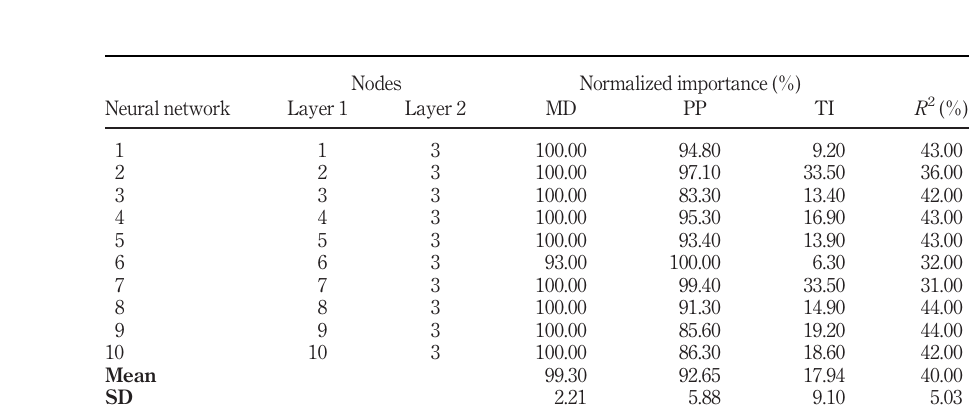
Table 3. Neural network residues – model